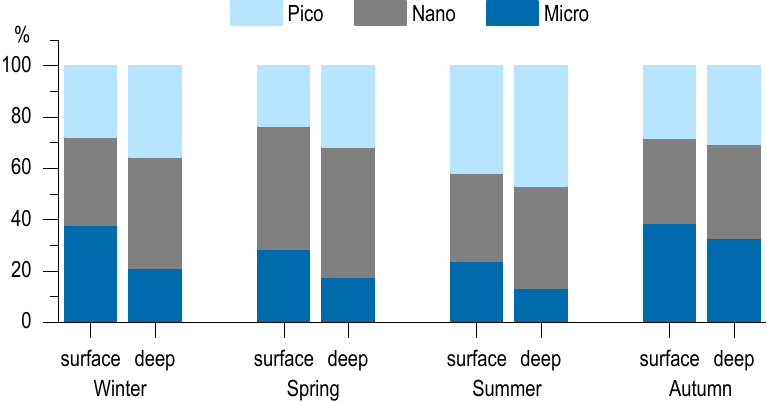
Figure 8. Phytoplankton functional type composition as emerge from HPLC analysis of pigments.